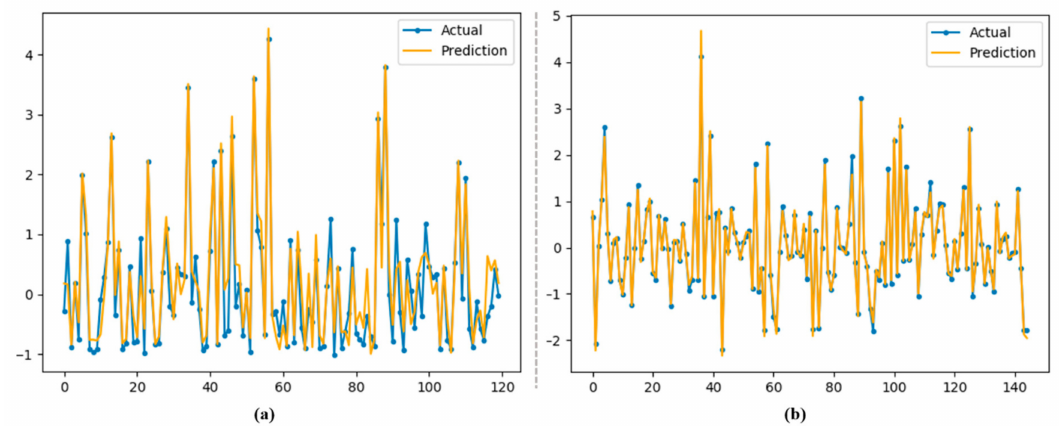
Figure 10. Visualization of performance of our proposed CNN with LSTM-AE over testing data for electricity prediction. ( a ) electricity consumption prediction for hourly data; ( b ) electricity prediction for daily data.